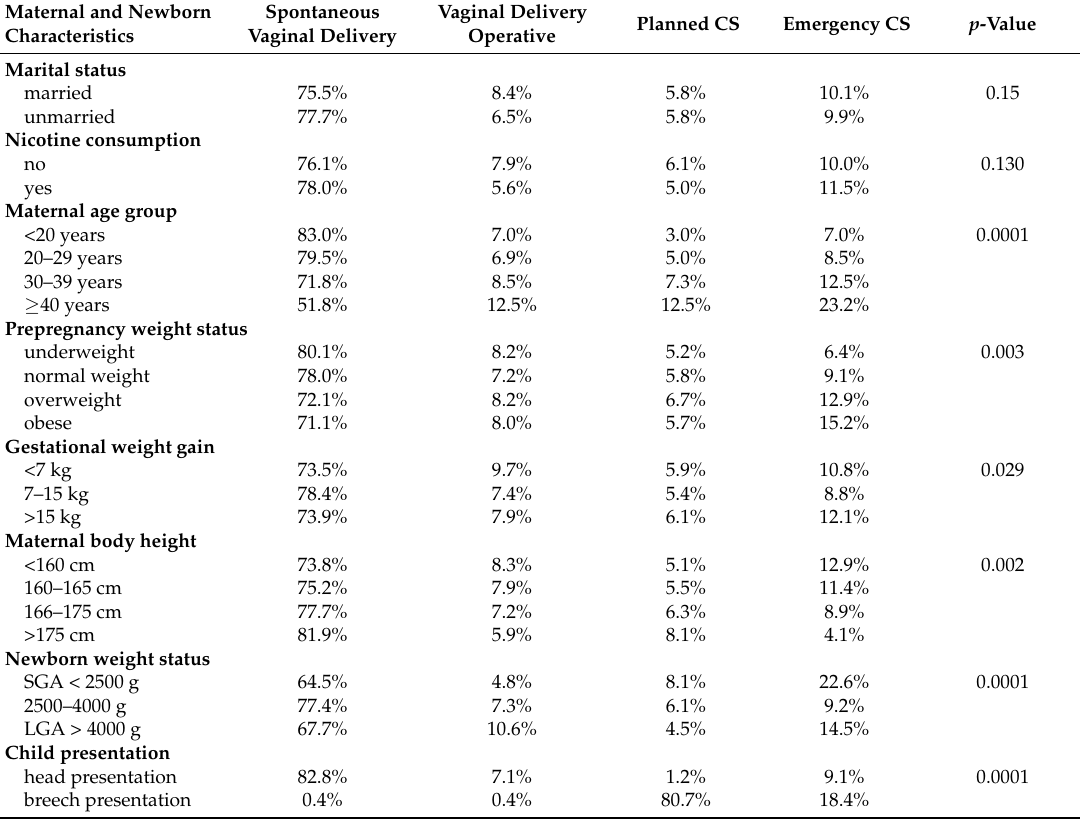
Table 4. Maternal and newborn characteristics according to delivery mode, χ 2 −